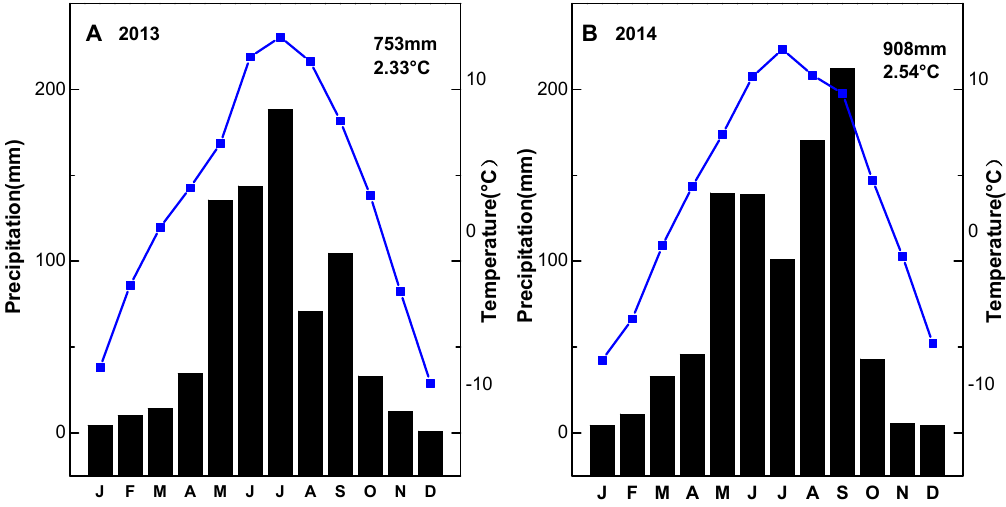
Figure 1. Monthly cumulative precipitation (black column) and air temperature (blue line) in 2013 ( A ) and 2014 ( B ) for the grazing experimental site. Values shown in each panel are total annual precipitation and mean temperature.